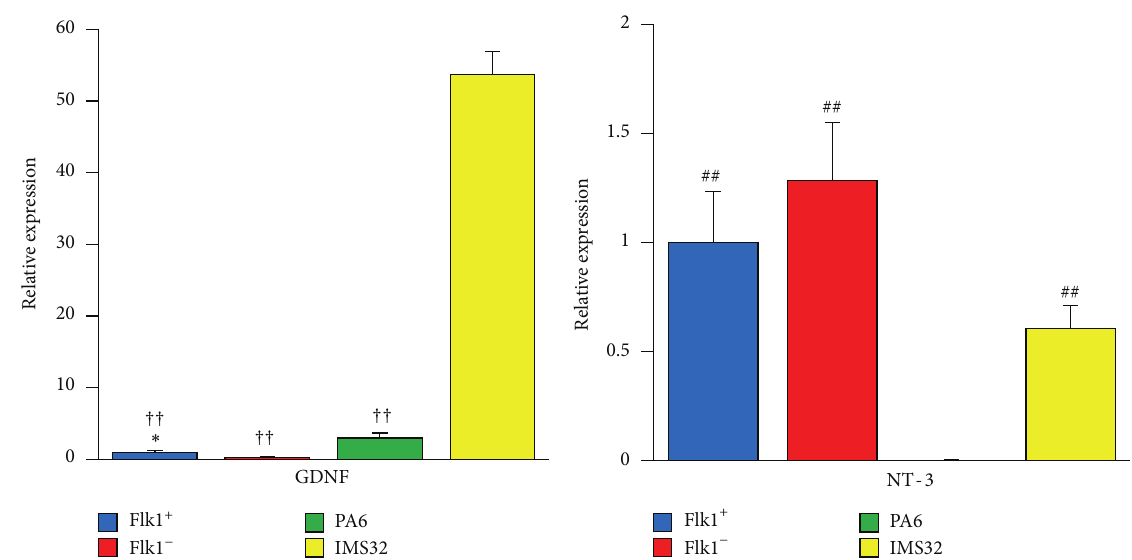
Figure 2: Transcript levels of angiogenic and neurotrophic factors in angioblast-like cells induced from ES cells (ES-ABs). Sorted ES-ABs expressed angiogenic and neurotrophic factors: VEGF-A, PDGF-A, FGF2, NGF, brain-derived neurotrophic factor (BDNF), glial cell line- derived neurotrophic factor (GDNF), Neurotrophin-3 (NT-3), and ciliary neurotrophic factor (CNTF). Each expression level of the factors compared Flk1 positive cells with Flk1 negative cells, PA6 cells, and IMS32 cells. PA6: a cell line of mouse mesenchymal stem cell and IMS32: a cell line of immortalized mouse Schwann cell. Flk1 + : Flk1 positive cells and Flk1 − : Flk1 negative cells. ∗ 𝑃 < 0.05 versus Flk1 − cells, ## 𝑃 < 0.005 versus PA6 cells, and †† 𝑃 < 0.005 versus IMS32 cells.